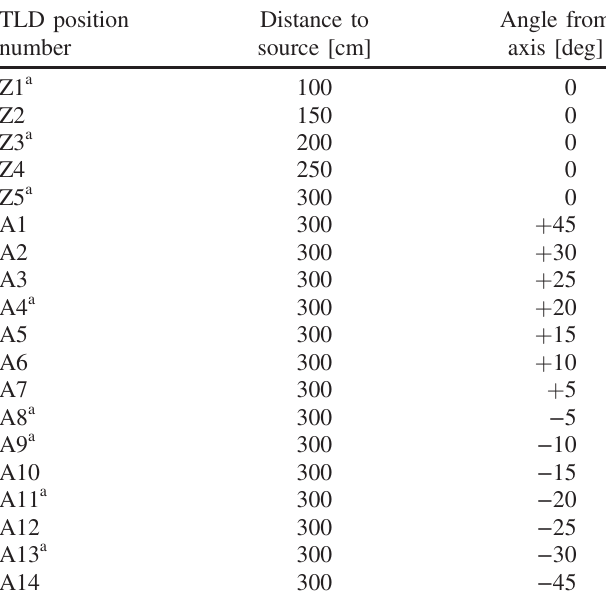
TABLE II. Locations of the far-field TLDs in this experimental campaign.